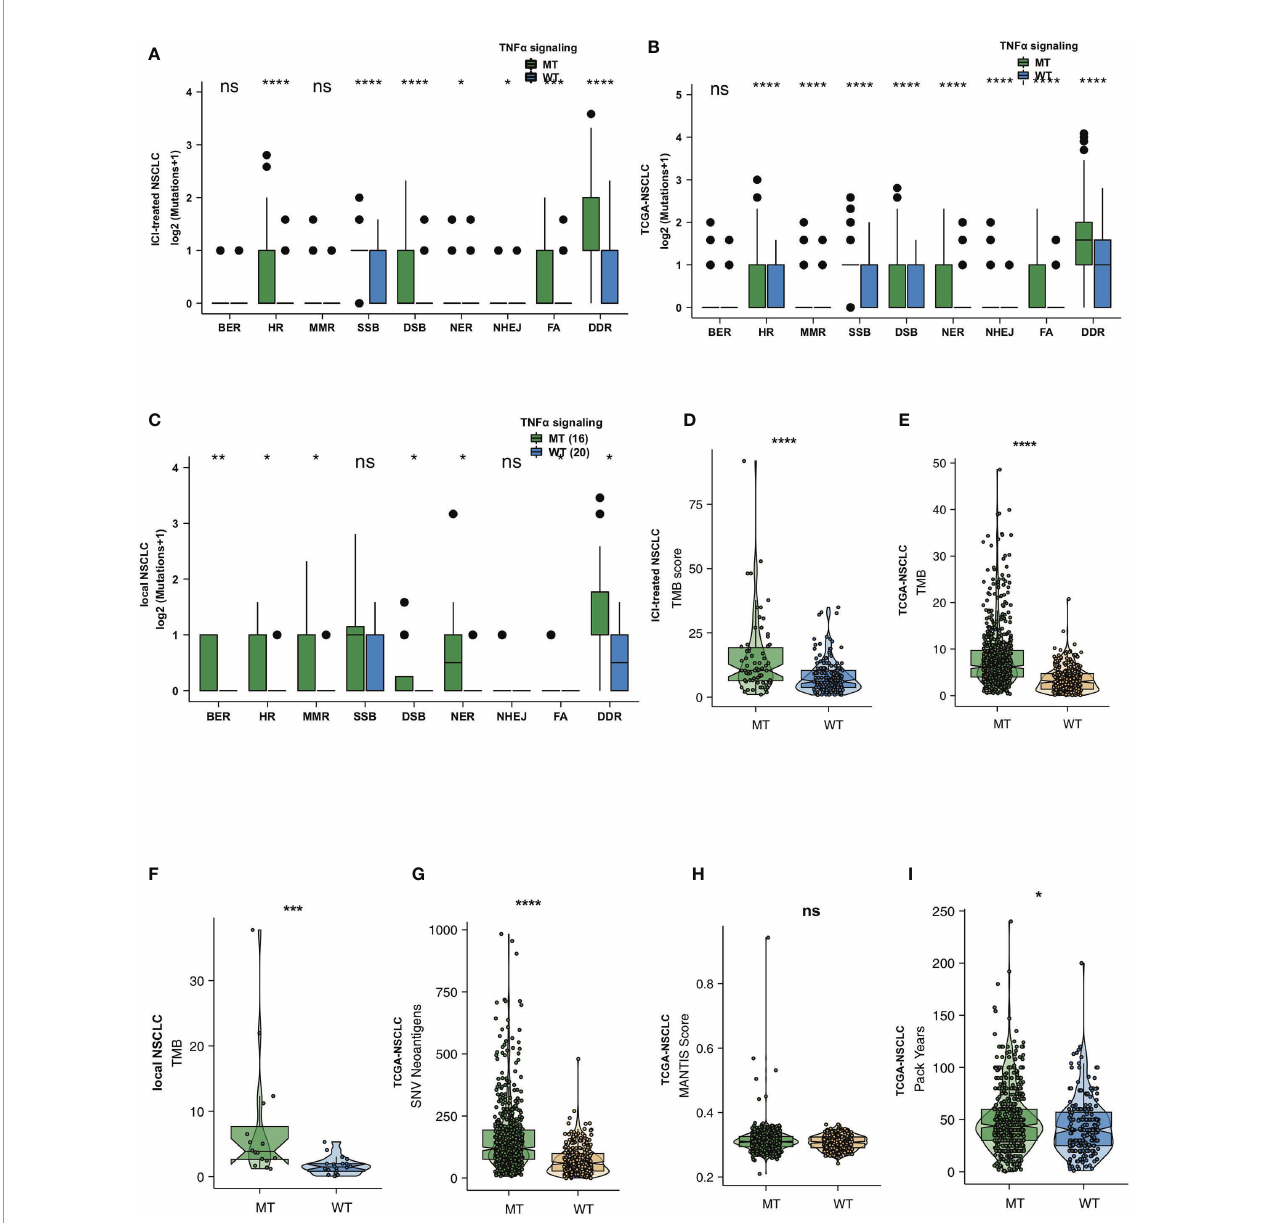
FIGURE 3 | TNF a -MT NSCLC was associated with enhanced tumor immunogenicity. Comparison of DNA damage-related gene set alterations between TNF a -MT and TNF a -WT tumors in the ICI-treated NSCLC (A) , TCGA-NSCLC (B) and local NSCLC (C) cohorts. Comparison of TMB between TNF a -MT and TNF a -WT tumors in the ICI-treated NSCLC (D) , TCGA-NSCLC (E) and local NSCLC (F) cohorts. Comparison of NAL between TNF a -MT and TNF a -WT tumors in the TCGA-NSCLC cohort (G) . Comparison of the MANTIS score between TNF a -MT and TNF a -WT tumors in the TCGA-NSCLC cohort (H) . Comparison of pack years between TNF a - MT and TNF a -WT tumors in the TCGA-NSCLC cohort (I) . (*P < 0.05; **P < 0.01; ***P < 0.001; and ****P < 0.0001; Wilcoxon rank-sum test). NSCLC, non small-cell lung cancer; TCGA, The Cancer Genome Atlas; ICI, immune checkpoint inhibitors. ns, not signi fi